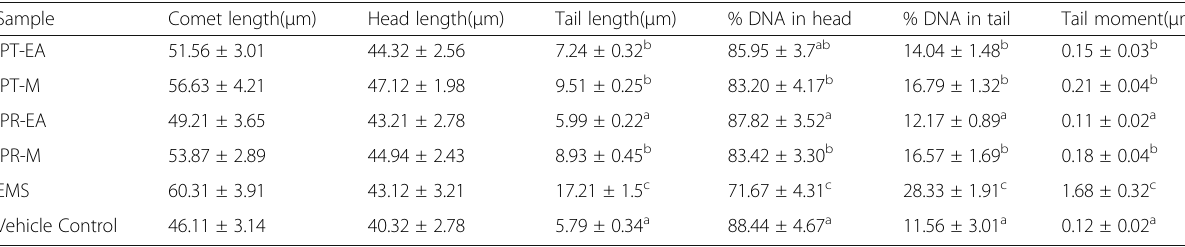
Table 4 Cytotoxicity assessment on blood lymphocytes by comet parameters Sample